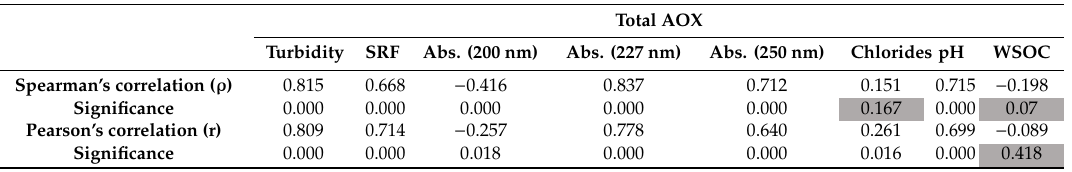
Table 1. Spearman and Pearson correlations for the correlation of the independent variables with the total adsorbable organic halides (AOX) concentration.